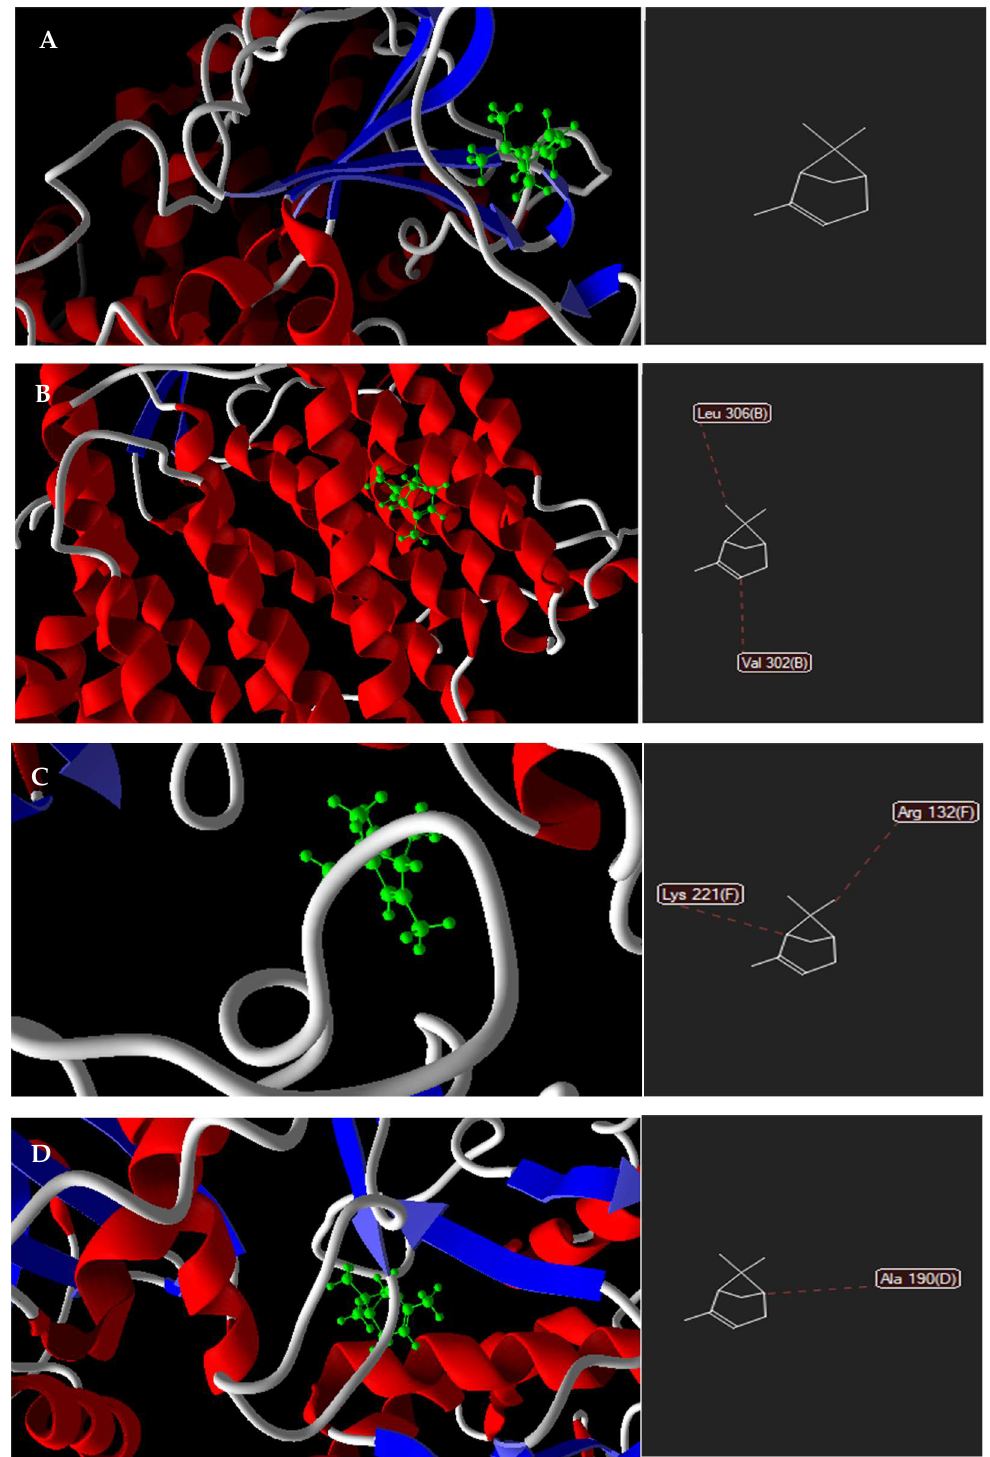
Figure 1. PDB ID protein— α -pinene interaction maps. ( A ) Map of interactions between the PDB protein ID 3JUV (14- α -demethylase) and α -pinene; ( B ) Map of interactions between the PDB ID 4QUV protein ( δ -14-sterol reductase) and α -pinene; ( C ) Map of interactions between the PDB ID 2J0Y protein (1,3- β -glucan synthase) and α -pinene; ( D ) Map of interactions between the PDB ID 3QJ7 protein (thymidylate synthase) and α-pinene.